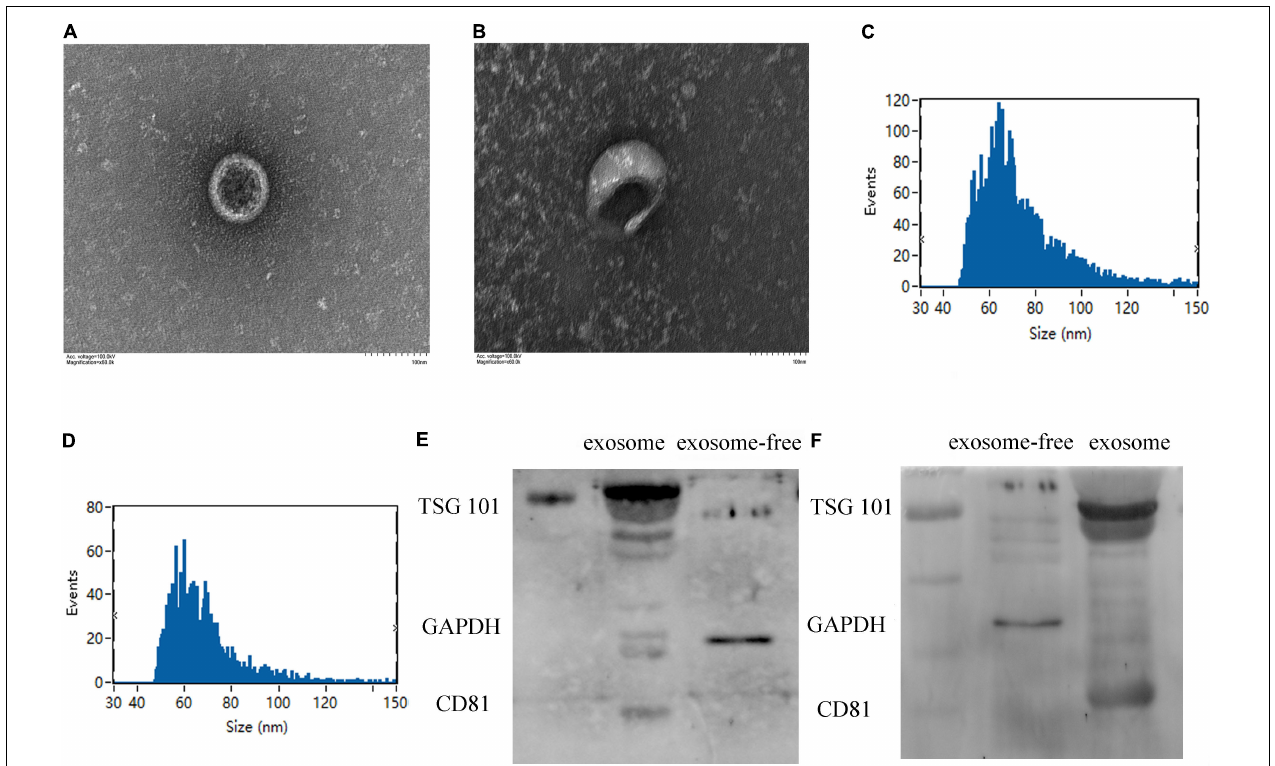
FIGURE 1 | Identification of plasma exosome using transmission electron microscopy (TEM) and Western blotting. (A,B) The specific morphology of plasma exosome in patients (A) and in healthy volunteers (B) was identified by TEM. (C,D) NanoFCM showed that the diameter of exosome ranged from 50 to 70 nm in patients (C) and in healthy volunteers (D) . (E,F) Compared to exosome-free protein, Western blot analysis shows that exosomes were positive for TSG101 and CD81 and negative for glyceraldehyde-3-phosphate dehydrogenase (GAPDH) in healthy volunteers (E) and in patients (F)